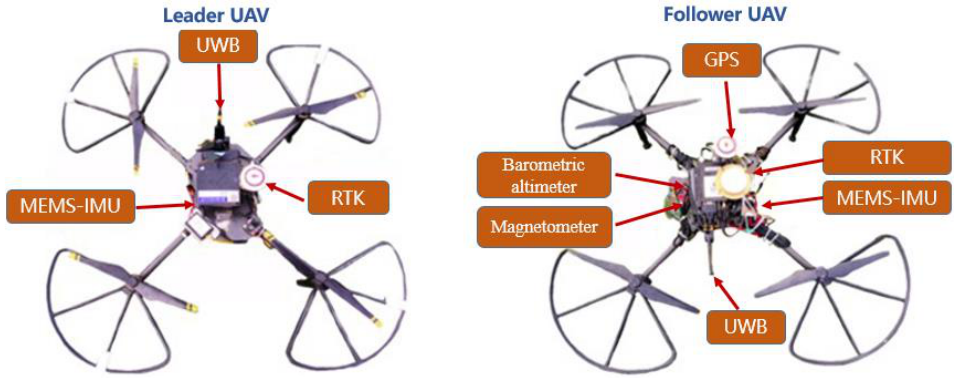
Figure 5. Sensor mounted on the UAVs in autonomous flight experiment. Table 1. The performance parameters of airborne sensors in the experiment. Airborne Sensor